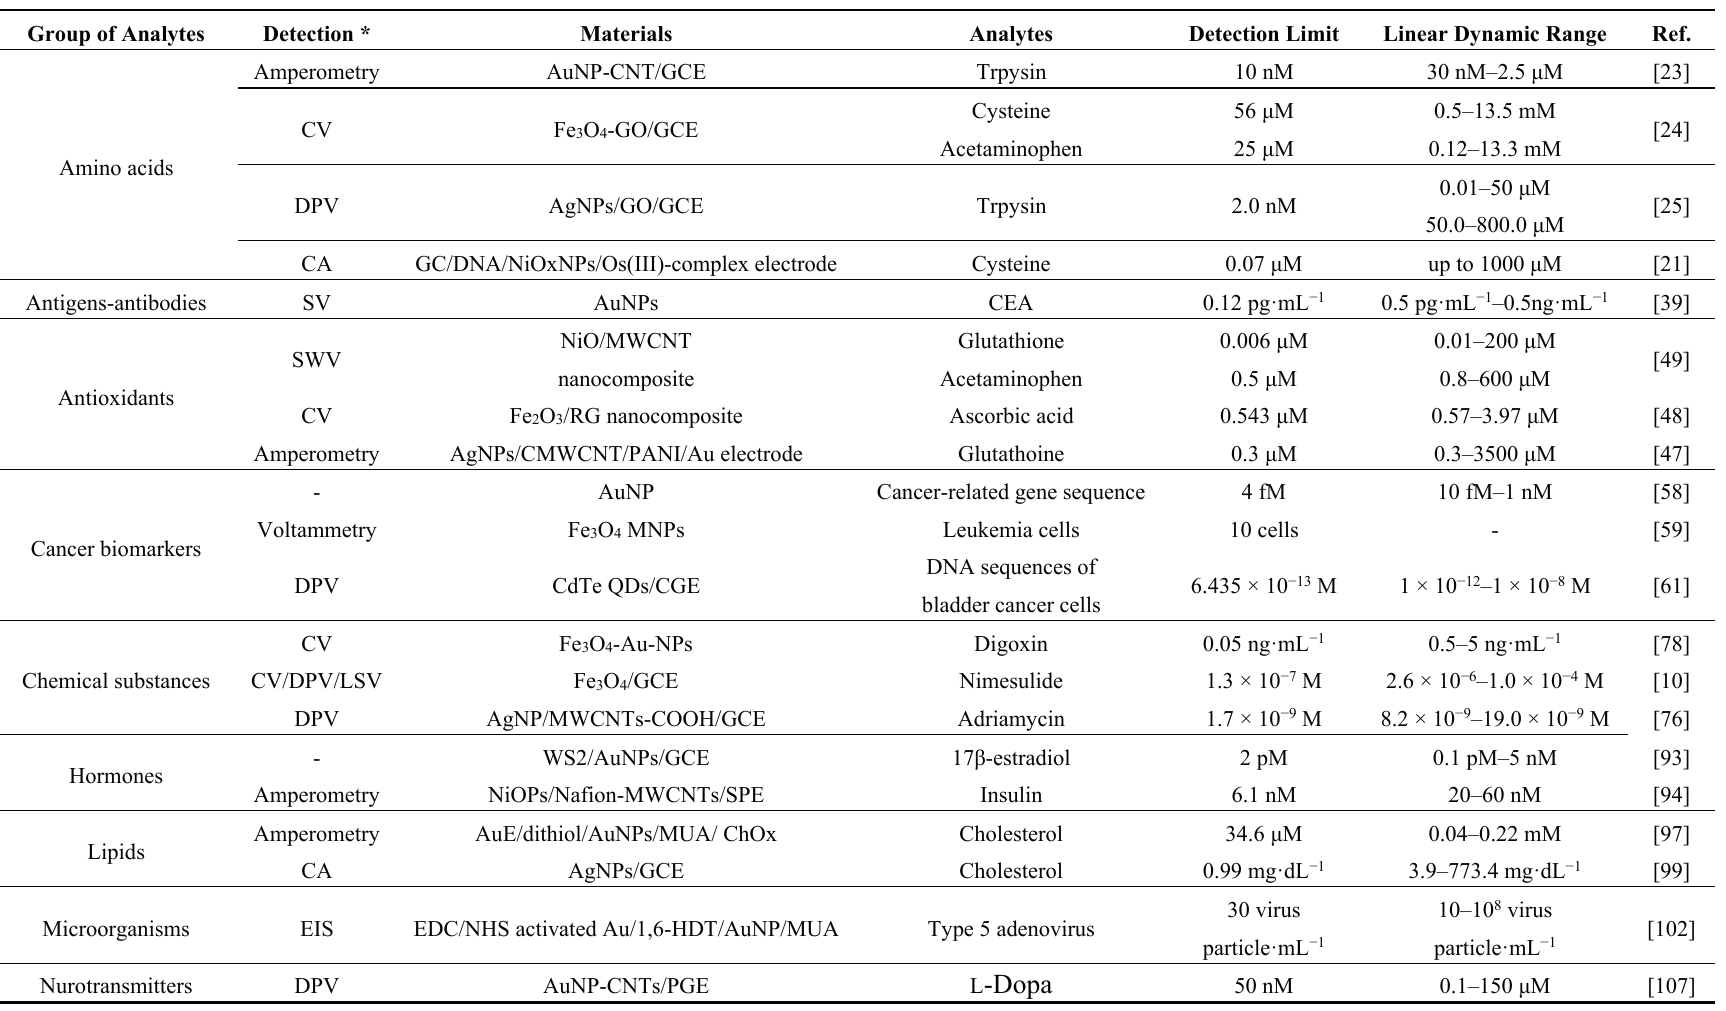
Table 1. Selected examples of recent reports on biomedical targets using various nanoparticles by electrochemical